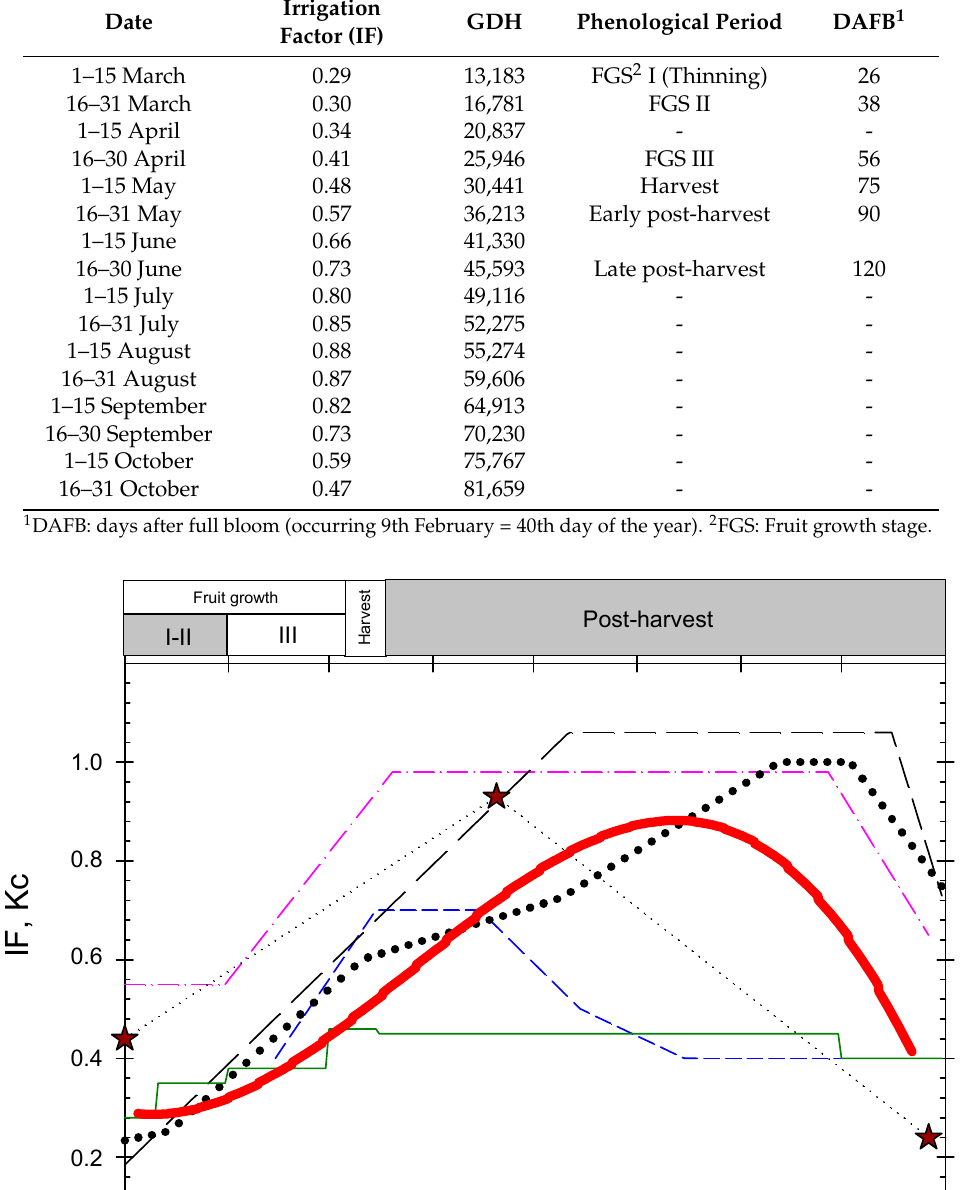
Table 3. Proposed irrigation factor (IF) and accumulated growing degree hours (GDH) for the different phenological stages for early maturing nectarine trees.